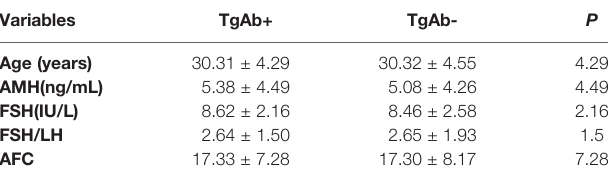
TABLE 4 | Comparison of TgAb+ and